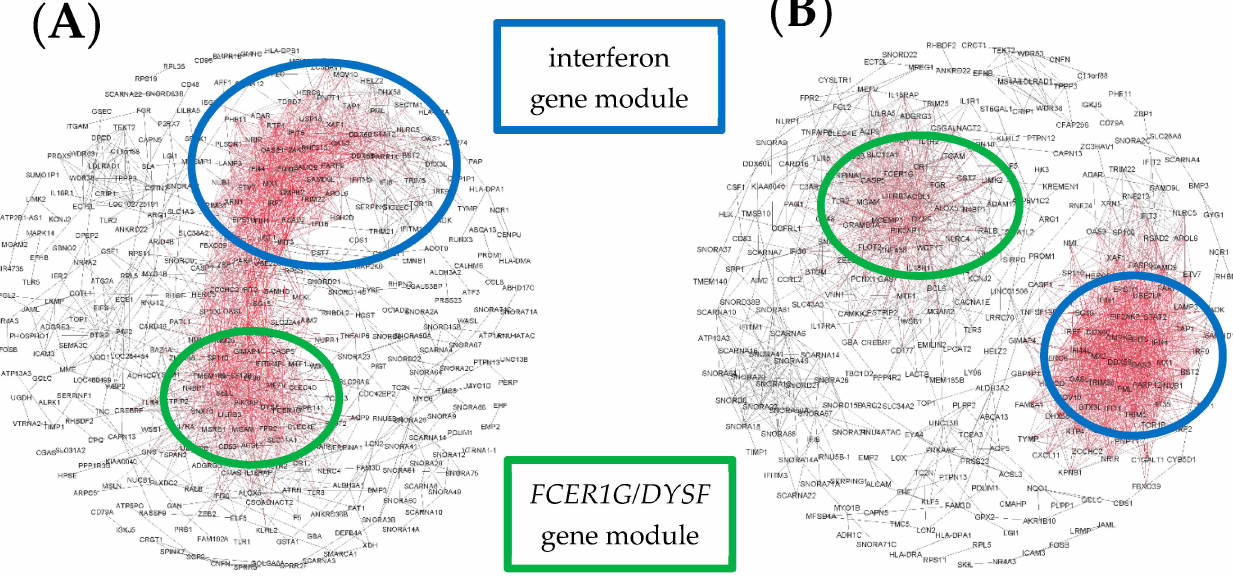
Figure 5. Illustrative examples of personal gene network structures generated in Gephi for representative subjects from Cluster B. Example ( A ) shows a network with overlapping modules, whereas Example ( B ) shows a network with two isolated modules. Red indicates highly connected genes (“hubs”) and black denotes genes with few